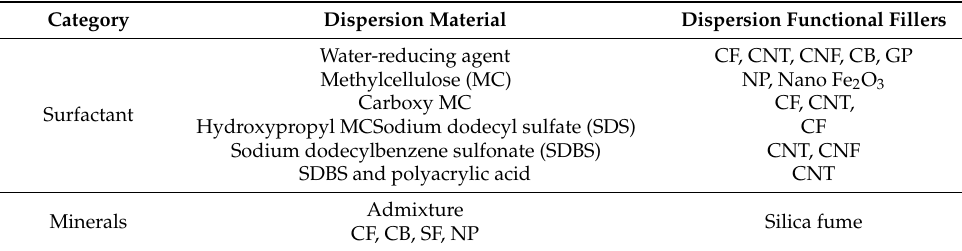
Table 2. Chemical dispersion materials. Reproduced with permission from [4], Elsevier,